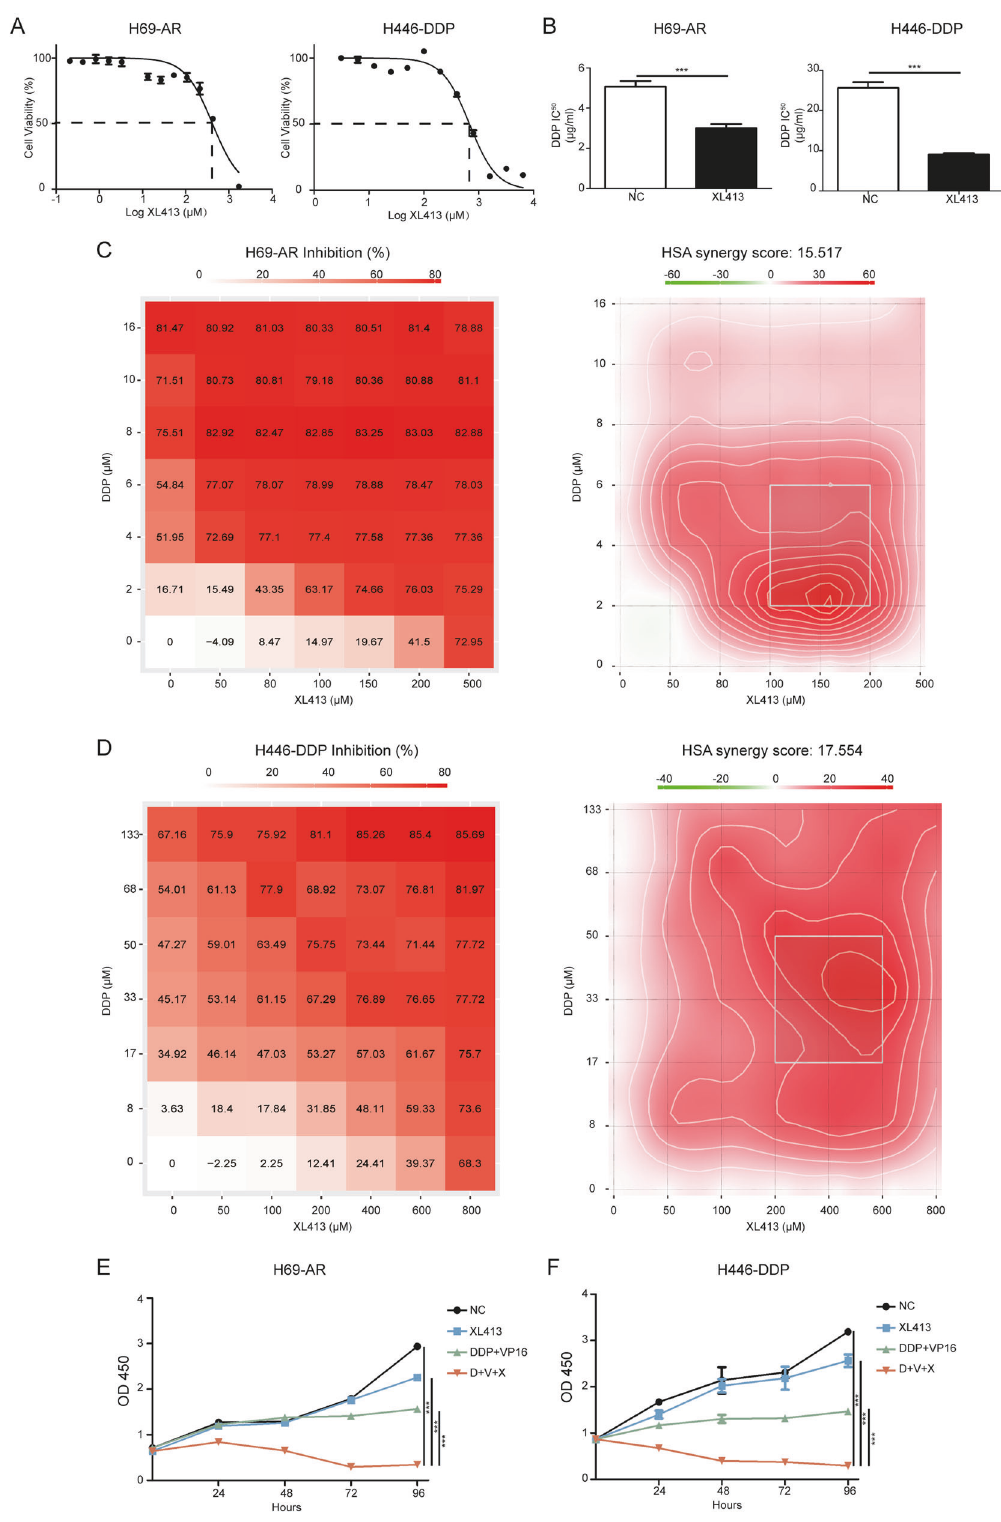
Fig. 3 CDC7 inhibitor XL413 shows synergistic effect with chemo-treatment in resistant SCLC cells. A IC 50 of XL413 in H69-AR(left) and H446-DDP(right) are 416.8 μ M and 681.3 μ M. B Comparison of DDP IC 50 with or without XL413 in H69-AR(left, XL413 50 μ M) and H446- DDP(right, 80 μ M). C Cell viability matrices of DDP and XL413 in H69-AR(left) and the HSA model heatmap(right). D Cell viability matrices of DDP and XL413 in H446-DDP(left) and the HSA model heatmap(right). E Cell viability of H69-AR treated with negative control, XL413(50 μ M), DDP, and VP16(1 μ g/ml, 100 μ g/ml) and combined treatment using CCK-8 assay. F Cell viability of H446-DDP treated with negative control, XL413(80 μ M), DDP, and VP16(5 μ g/ml, 80 μ g/ml) and combined treatment using CCK assay.